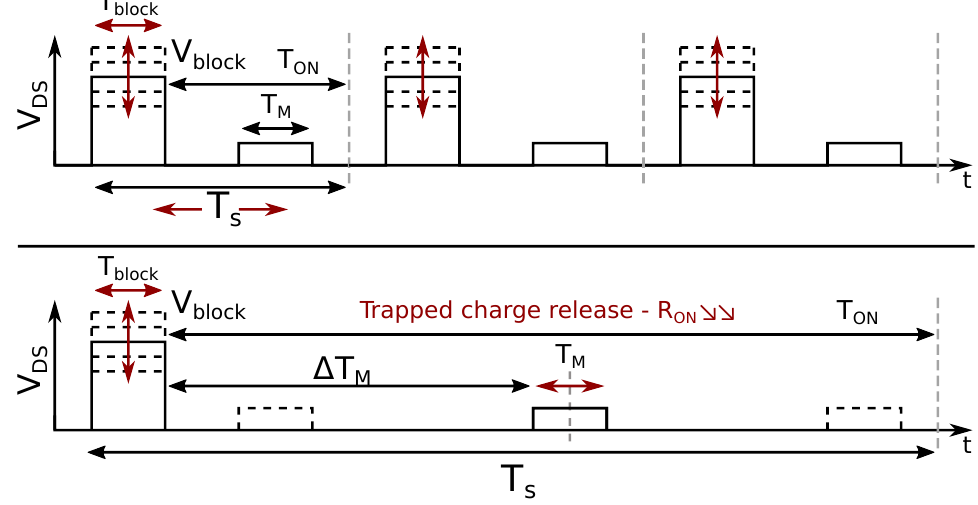
Figure 2. Two different measurement regimes. Upper: direct characterization of R ON ( f S ) varying the period T S = 1/ f S . Lower: indirect characterization of R ON ( f S ) at fixed period T S and varying ∆ T M